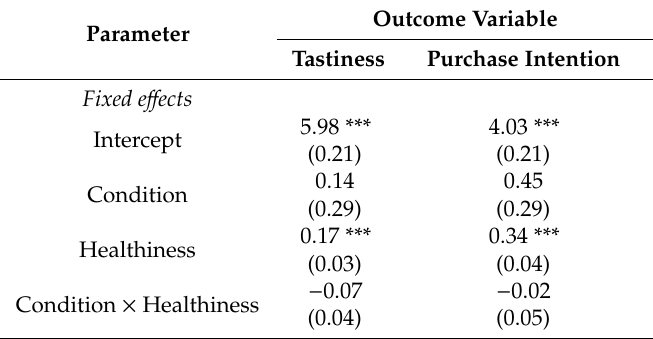
Table 8. Parameter estimates of the e ff ects of healthiness and condition on tastiness expectations and purchase intentions, using linear mixed-e ff ect model